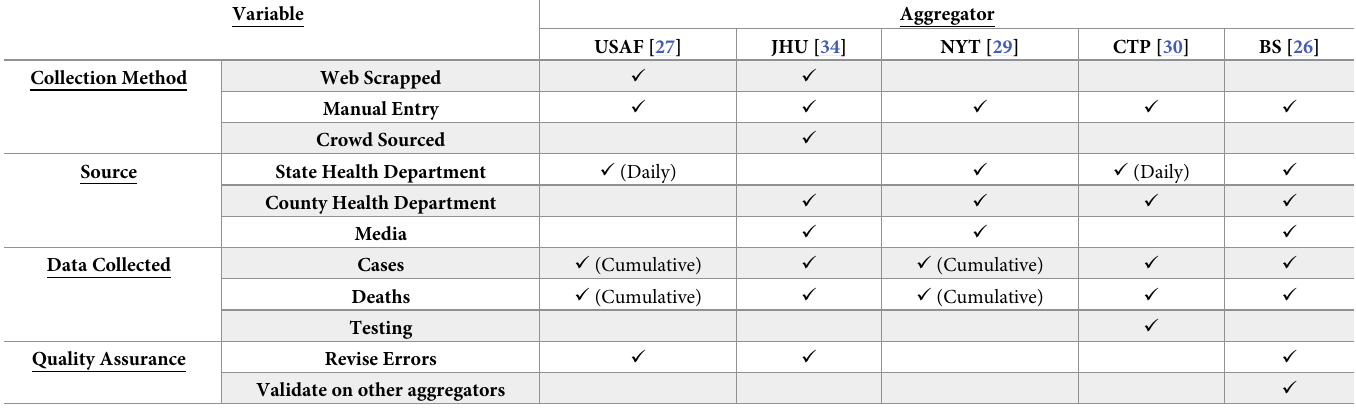
Table 1. Aggregator data collection